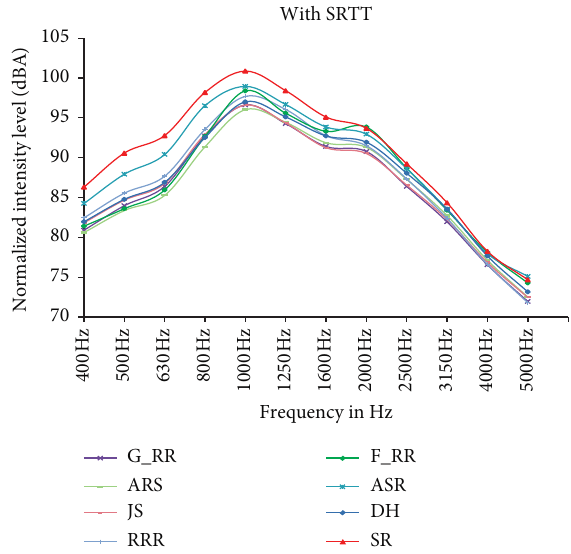
Figure 5: Frequency responses for DGA pavement